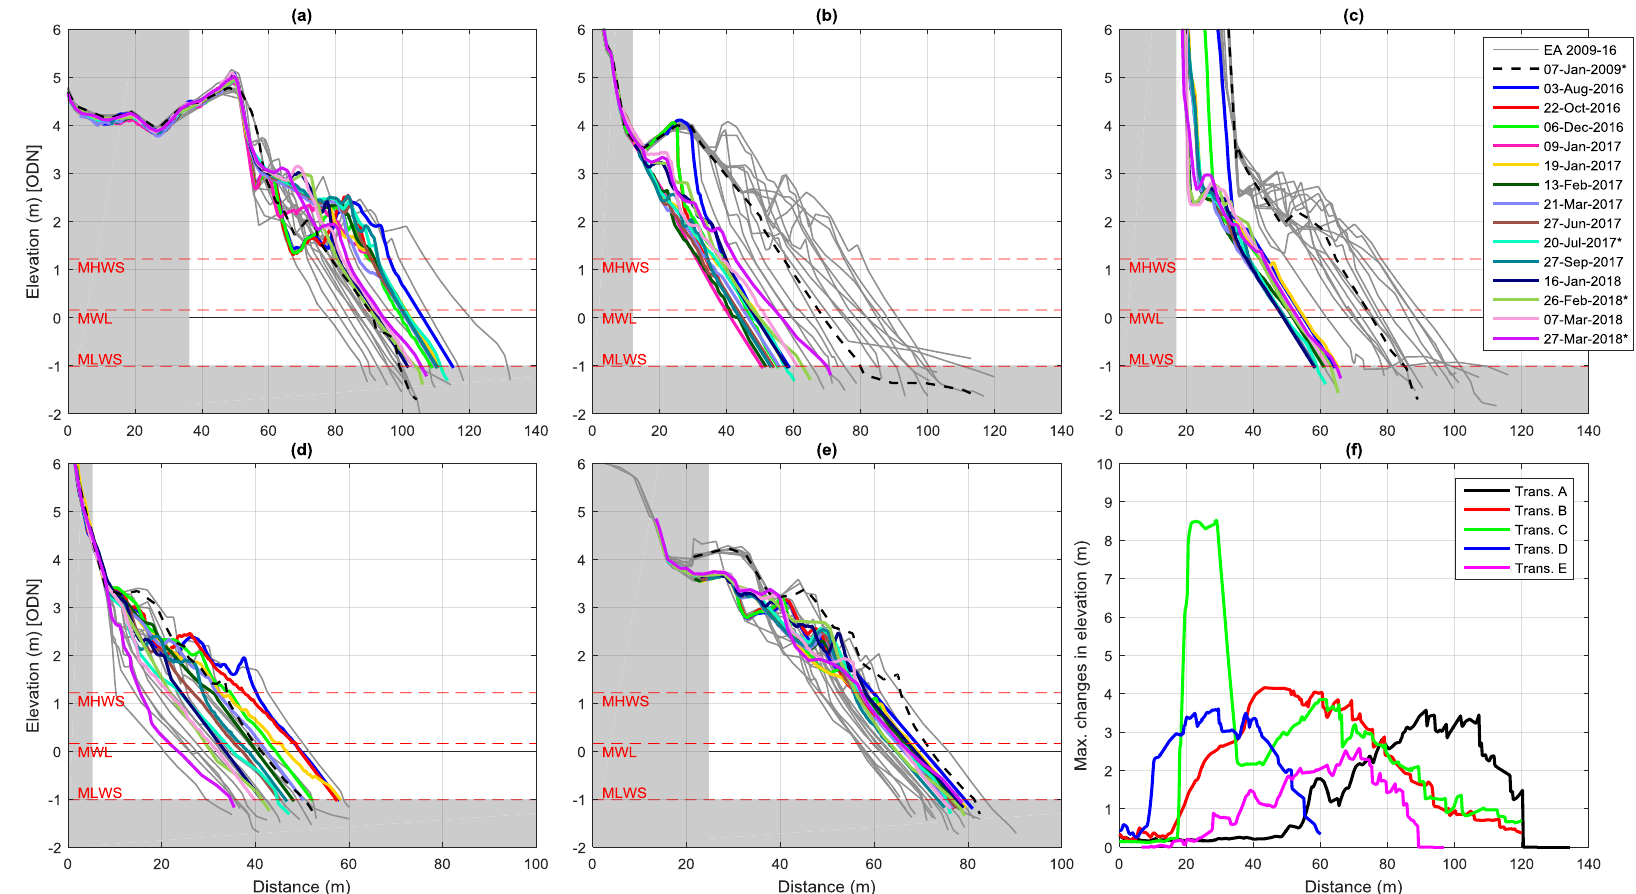
Figure 4. ( a – e ) Cross-shore profiles measured along Transects A–E (respectively) between January 2009 and February 2018 are shown to give an indication of the profile envelope and range of variations. Biannual measurements by the Environment Agency (EA) are shown in grey (the earliest one as a black dashed line for reference), and dataset 2 measurements are shown in colour. ( f ) Maximum changes in elevation observed along each transect. Note that the areas shaded in grey were excluded from the calculations of profile area presented elsewhere in this